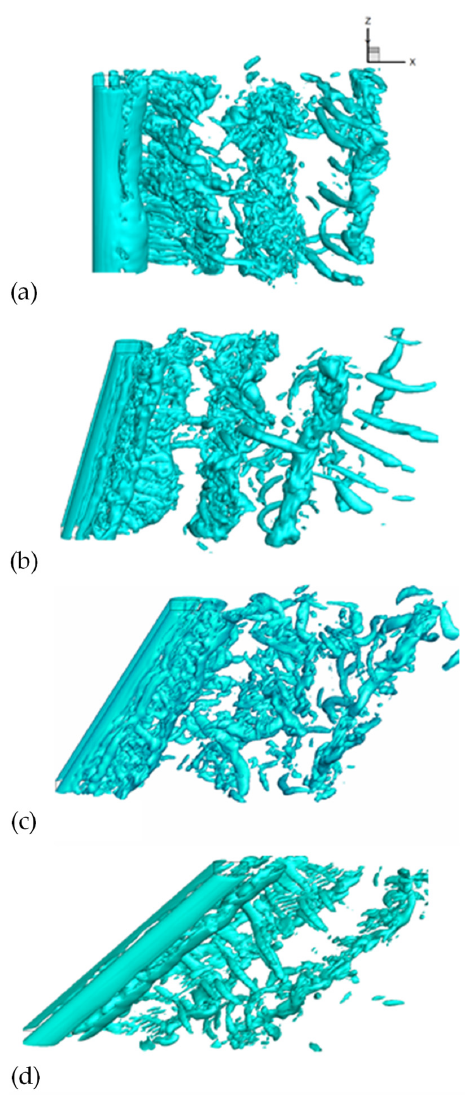
Figure 10. Instantaneous iso-surfaces of λ 2 for different yaw angles at the same phase ( λ 2 = − 1). ( a ) α = 0°; ( b ) α = 15°; ( c ) α = 30°; ( d ) α = 45°. For a better view of the shedding process of the spanwise vortices, the evolution of the spanwise vorticity ω z contours viewed on the ( x , y ) plane is of interest to investigate. Prior to examining the spanwise vorticity on the ( x , y ) plane, the time-averaged stream- lines at different yaw angles are firstly depicted in Figure 11. As the plane is extracted at z = 4 D , the coordinate of the cylinder center varies with the yaw angle. At α = 0°, a pair of counter-rotating vortices show up right downstream of the cylinder in a symmetric form. The foci and saddle points can be clearly identified in the figure. The saddle point locates at approximately x = 1.1 D (measured from the center of the square), which is the same as that found by Oudheusden et al. [43]. At the upper and lower edges of the cylinder, two recirculation regions can be observed, which also show that there is no reattachment to the cylinder wall for the flow separated from the leading edge. This recirculation region, however, is found to be absent in the wake of a circular cylinder. When α increases to 15°, although the recirculation regions on upper and lower edges still exist, the counter-rotat- ing vortex pairs are hardly identified due to the generation of the spanwise velocity. This phenomenon, according to Najafi et al. [44], takes place at α = 25° for a circular cylinder.